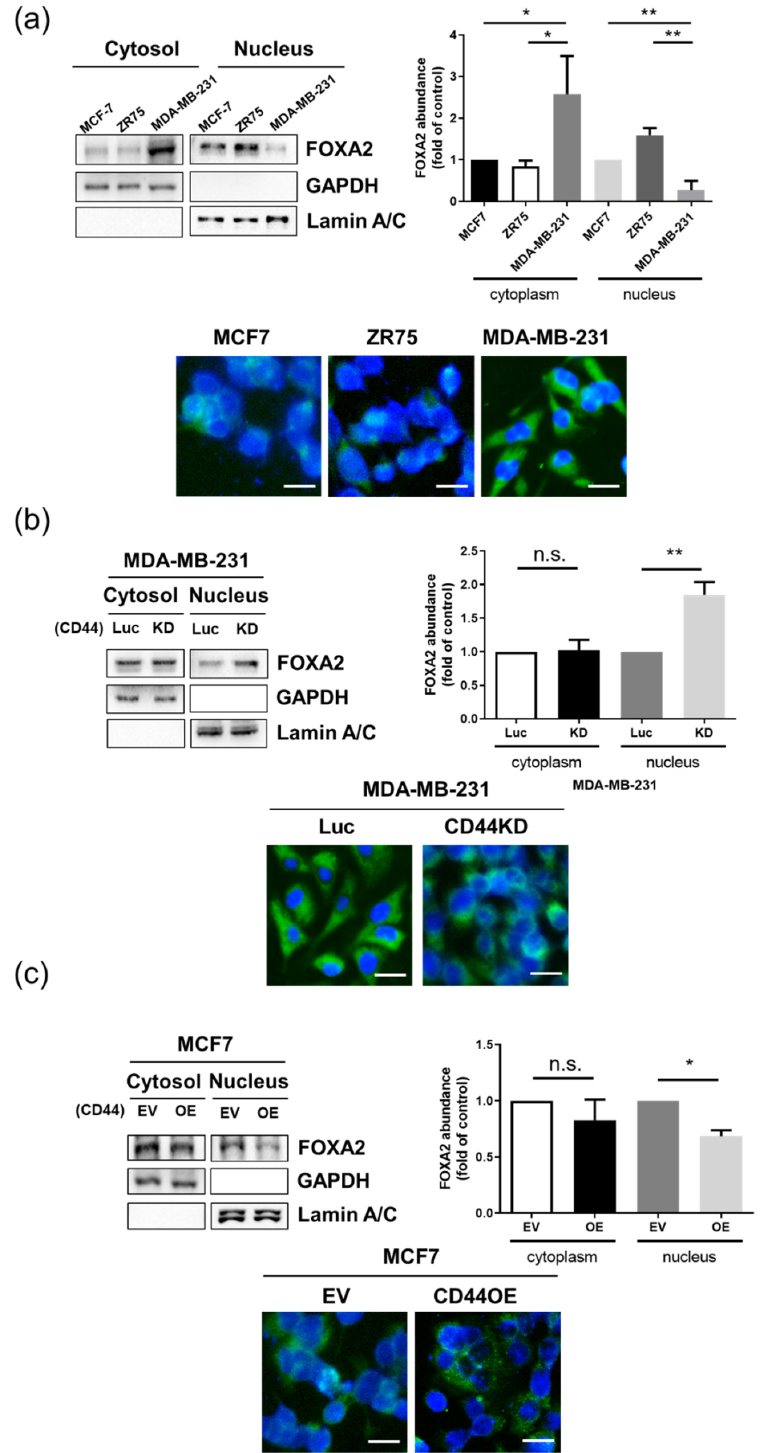
Figure 5. FOXA2 accumulates in the nucleus in CD44 low breast cancer cells: ( a ) Immunoblotting, quantification, and immunofluorescence staining of nuclear and cytoplasmic FOXA2 protein in MDA-MB-231, ZR75, and MCF7 cells. ( b ) Immunoblotting, quantification, and immunofluorescence staining of nuclear and cytoplasmic FOXA2 protein in CD44 knockdown MDA-MB-231 cells. ( c ) Immunoblotting, quantification, and immunofluorescence staining of nuclear and cytoplasmic FOXA2 protein in CD44-overexpressed MCF7 cells. n.s. stands for not significant. Scale bar = 50 μ m. The data are presented as the mean ± SD. * Indicates p < 0.05, and ** indicates p < 0.01.